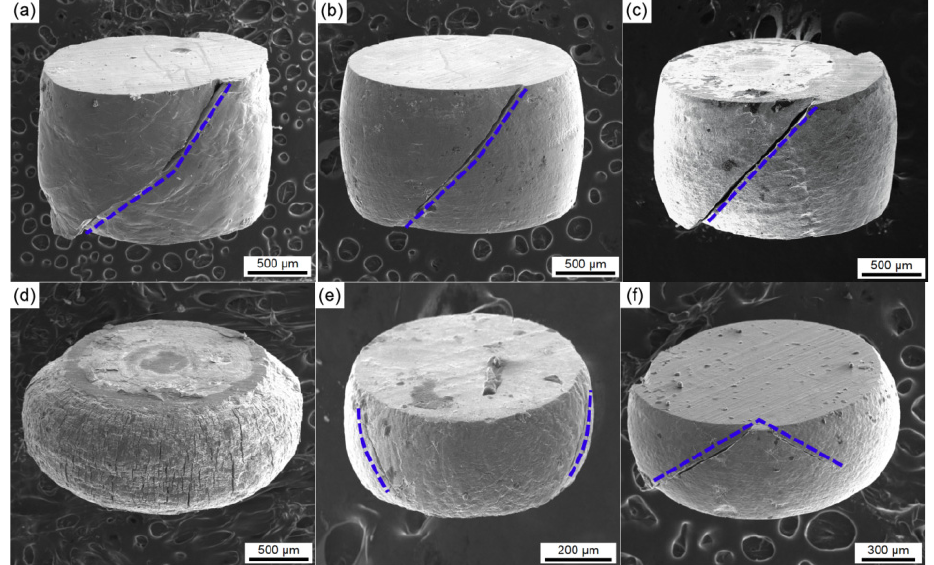
Figure 8. The surface morphology of the compressed equiaxed microstructure specimens under different specimen sizes and current densities: ( a ) 1.5 mm–0 A/mm 2 , ( b ) 1.5 mm–30 A/mm 2 , ( c ) 1.5 mm–50 A/mm 2 , ( d ) 1.5 mm–70 A/mm 2 , ( e ) 0.5 mm–50 A/mm 2 , ( f ) 1 mm–50 A/mm 2